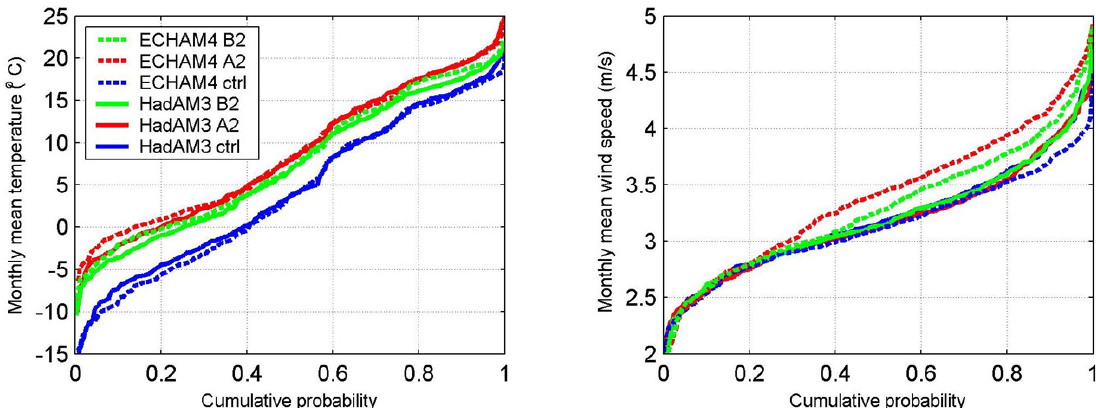
Fig. 1. Simulated changes in cumulative probabilities of monthly mean temperatures and wind speeds in the RCAO climate model simulations for Valkea-Kotinen, with both A2 and B2 scenarios as well as with both HadAM3 and ECHAM4 general circulation model boundary forcing (modified from Saloranta et al., 2009).